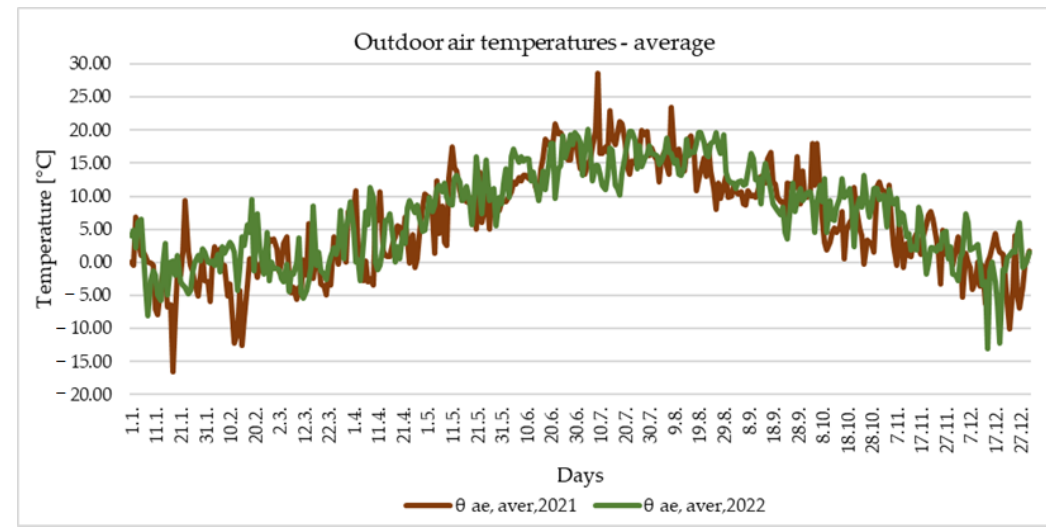
Figure 6. Average outdoor air temperatures in 2021 and 2022.